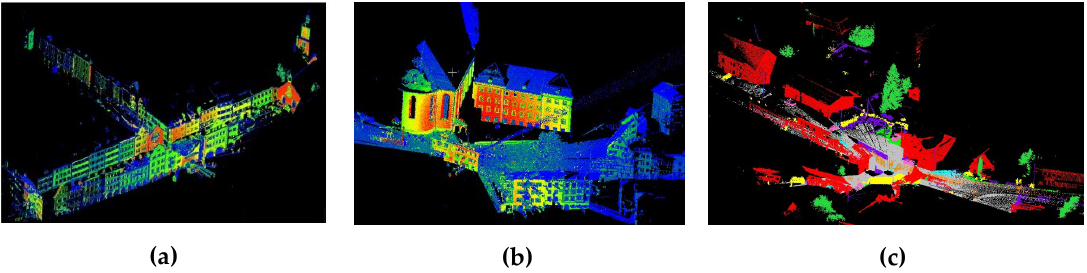
Figure 13. ( a ) The Market datasets (marketsquarefeldkirch4-reduced). ( b ) The Stgallen datasets (stgallencathedral6-reduced). ( c ) The Station datasets (untermaederbrunnen1). Table 1. Comparison of the speed and accuracy of four ICP